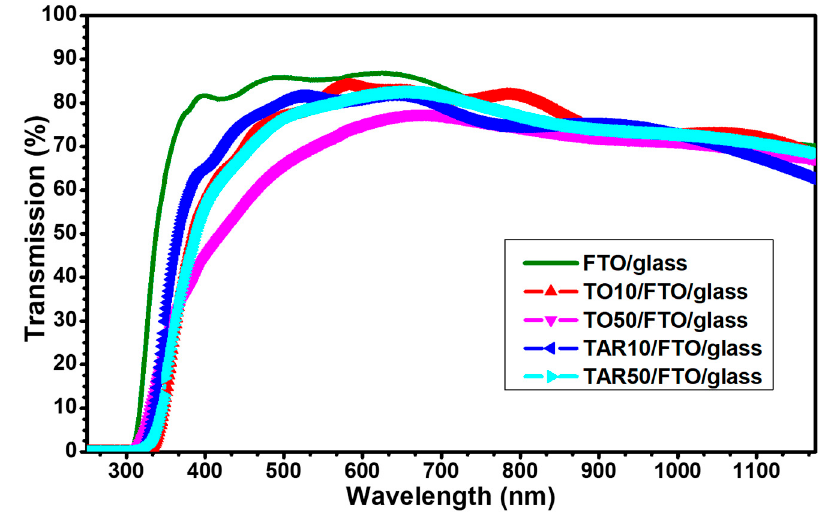
Figure 7. Transmission spectra of mesoporous TiO 2 film and of TiO 2 buffer layers deposited by PLD on FTO glass substrates.